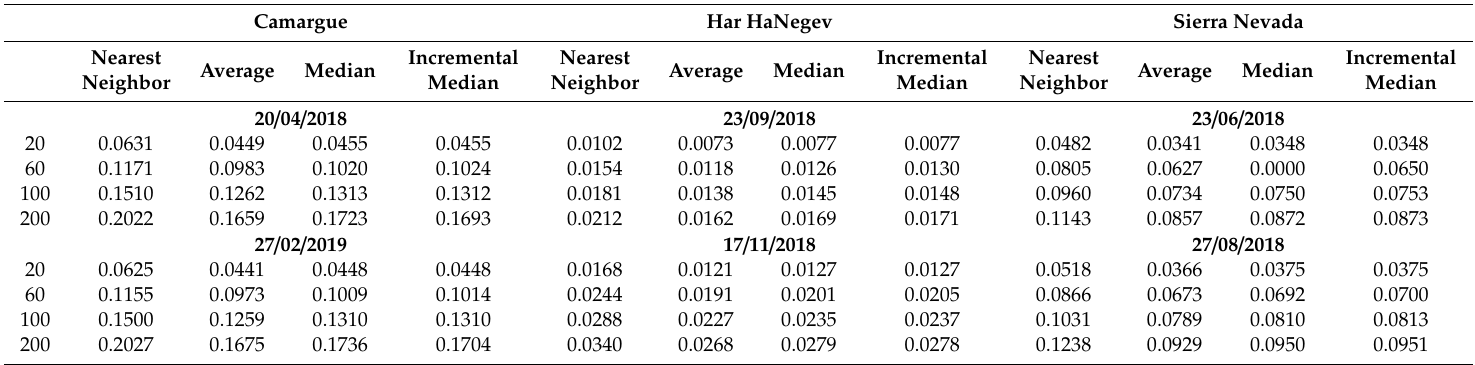
Table 10. Root Mean Square Error (RMSE) for each resampled image, considering the original 10 m image as the certain value. The scenarios that do not need to zoom out to show the whole protected area in the web map browser have numbers in